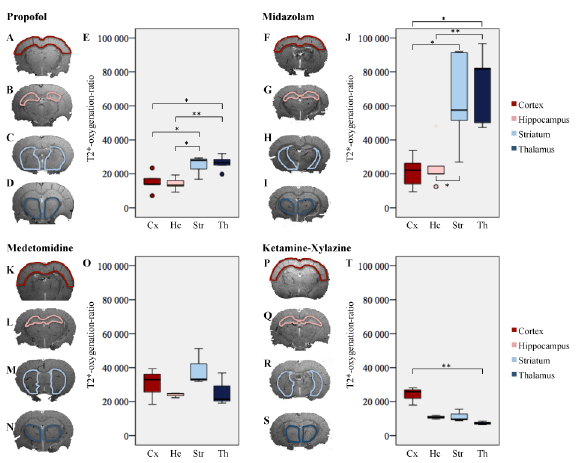
Figure 4. Comparison of T2*-oxygenation-ratio of intravenous anesthetics among brain regions. Images are coronal T2* MRI sections acquired in vivo under general anesthesia using propofol (A: cortex, B: hippocampus, C: striatum, D: thalamus), midazolam (F: cortex, G: hippocampus, H: striatum, I: thalamus), medetomidine (K: cortex, L: hippocampus, M: striatum, N: thalamus) or ketamine-xylazine (P: cortex, Q: hippocampus, R: striatum, S: thalamus). Box plots represents median, 25 th and 75 th percentile, minimum and maximum values, outliers ( u ) and extremes (*). Y-axis: regional T2*-oxygenation-ratio. X-axis: Cx, cortex; Hc, hippocampus; Str, stiatum; Th, thalamus. E: T2*-oxygenation-ratio for propofol. J: T2*-oxygenation-ratio for midazolam, O: T2*-oxygena- tion-ratio for medetomidine, T: T2*-oxygenation-ratio for ketamine- xylazine. * p , 0.05, ** p , 0.01.